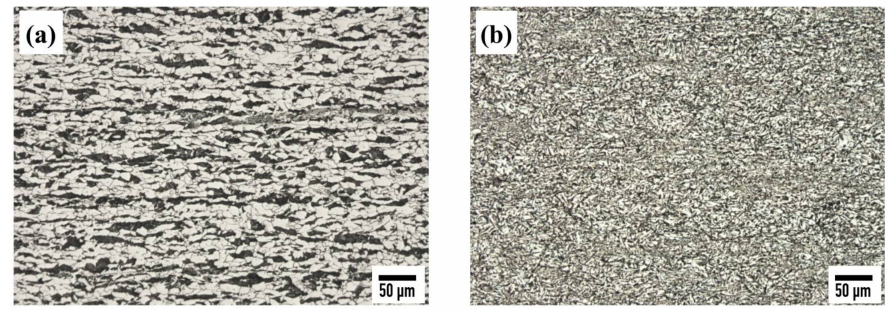
Figure 6. As-hot-rolled microstructure of 22MnB5 steel alloyed with Nb ( a ) and Mo + Nb ( b